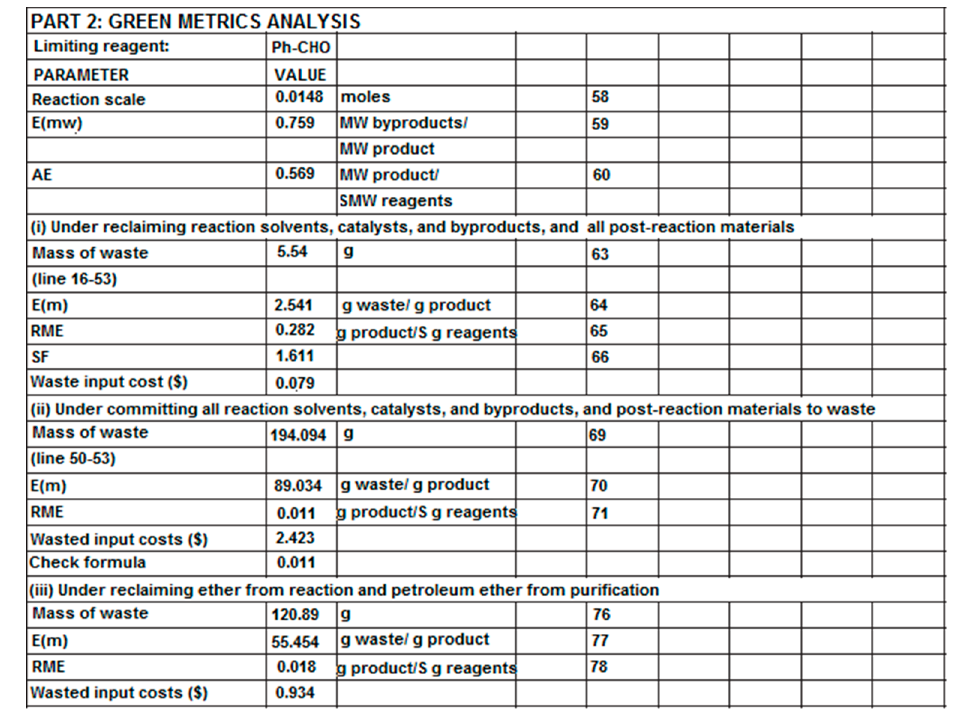
Figure 3. Reaction metrics to calculate the RME. Adapted from Ref. [48].